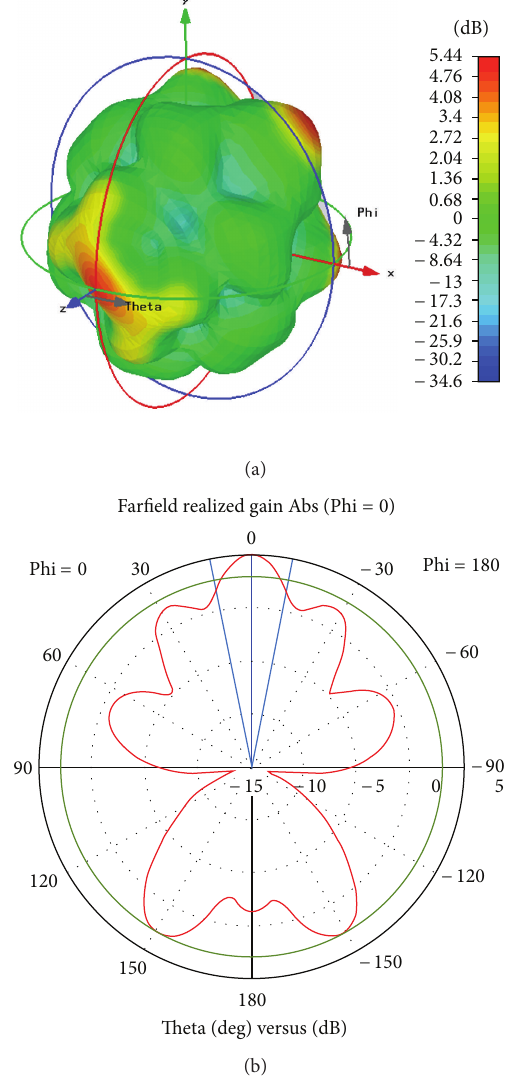
Figure 5: Radiation pattern of crossed dipole: (a) 3D pattern and (b) 2D elevation cuts at phi = 0 ∘